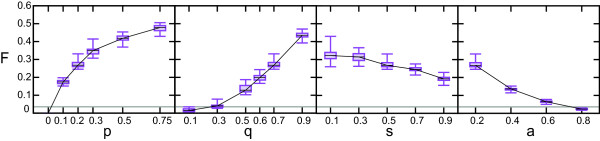
The fraction of interparalog edges for the extended DD model under different parameter conditions. As is the case for ΔD values, an increase in values of p and q and decrease of a lead to higher fraction of edges that connect paralogs in the network, divergence symmetry s has very little effect. Note that low values of p already have a large impact on the fraction of edges connecting paralogs: with p = 0.2 and a = 0.2, the probability of gaining an edge between daughter nodes after a duplication event in the network is p*(1-a) = 0.16, yet this small probability of an edge gain between daughter nodes after duplication leads to ~30% of all edges connecting paralogs. Default parameter conditions are p = 0.2, q = 0.7, s = 0.5, a = 0.2, each plot shows the fraction of interparalog edges when one of these parameters is varied while the others are kept at default values (for full parameter sweeps we refer to Figure S18). The gray line is the fraction of edges that connect paralogs of the yeast LC PIN. Boxes show the .25 and .75 percentile of 20 runs, the error bars show the extreme values and the black line is the mean of 20 runs.